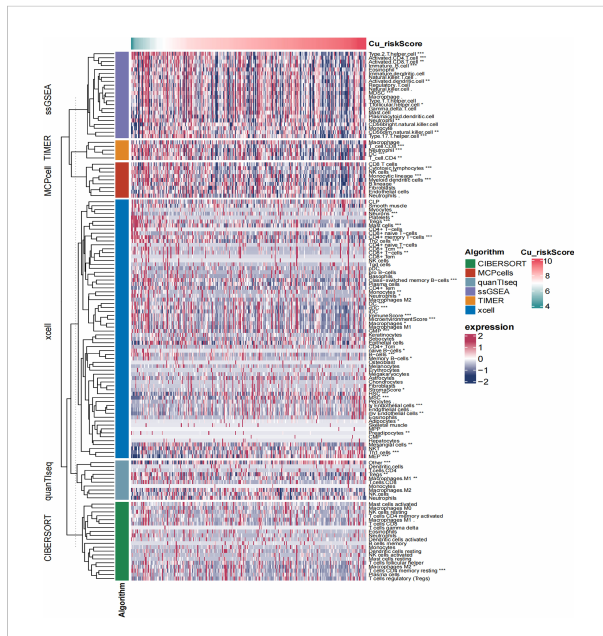
FIGURE 5 Heatmap showing the landscape of immune in fi ltration based on Cu_riskScore. *P < 0.05, **P < 0.01, ***P <